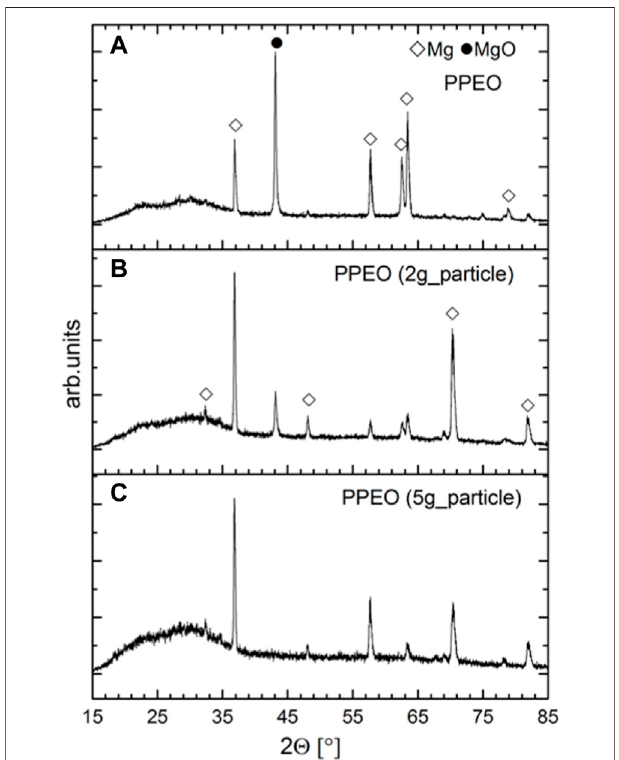
FIGURE 2 | XRD patterns of the PEO coatings. (A) PPEO, (B) PPEO (2 g_particle), and (C) PPEO (5 g_particle).